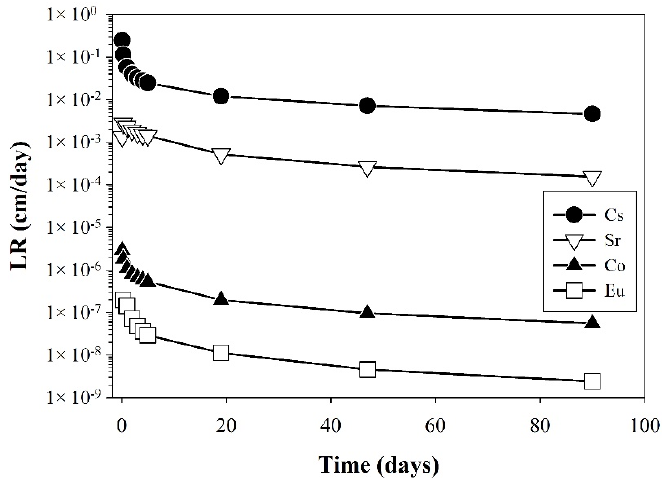
Figure 5. Leaching rates of nuclides (Cs, Sr, Co, and Eu) from the cement